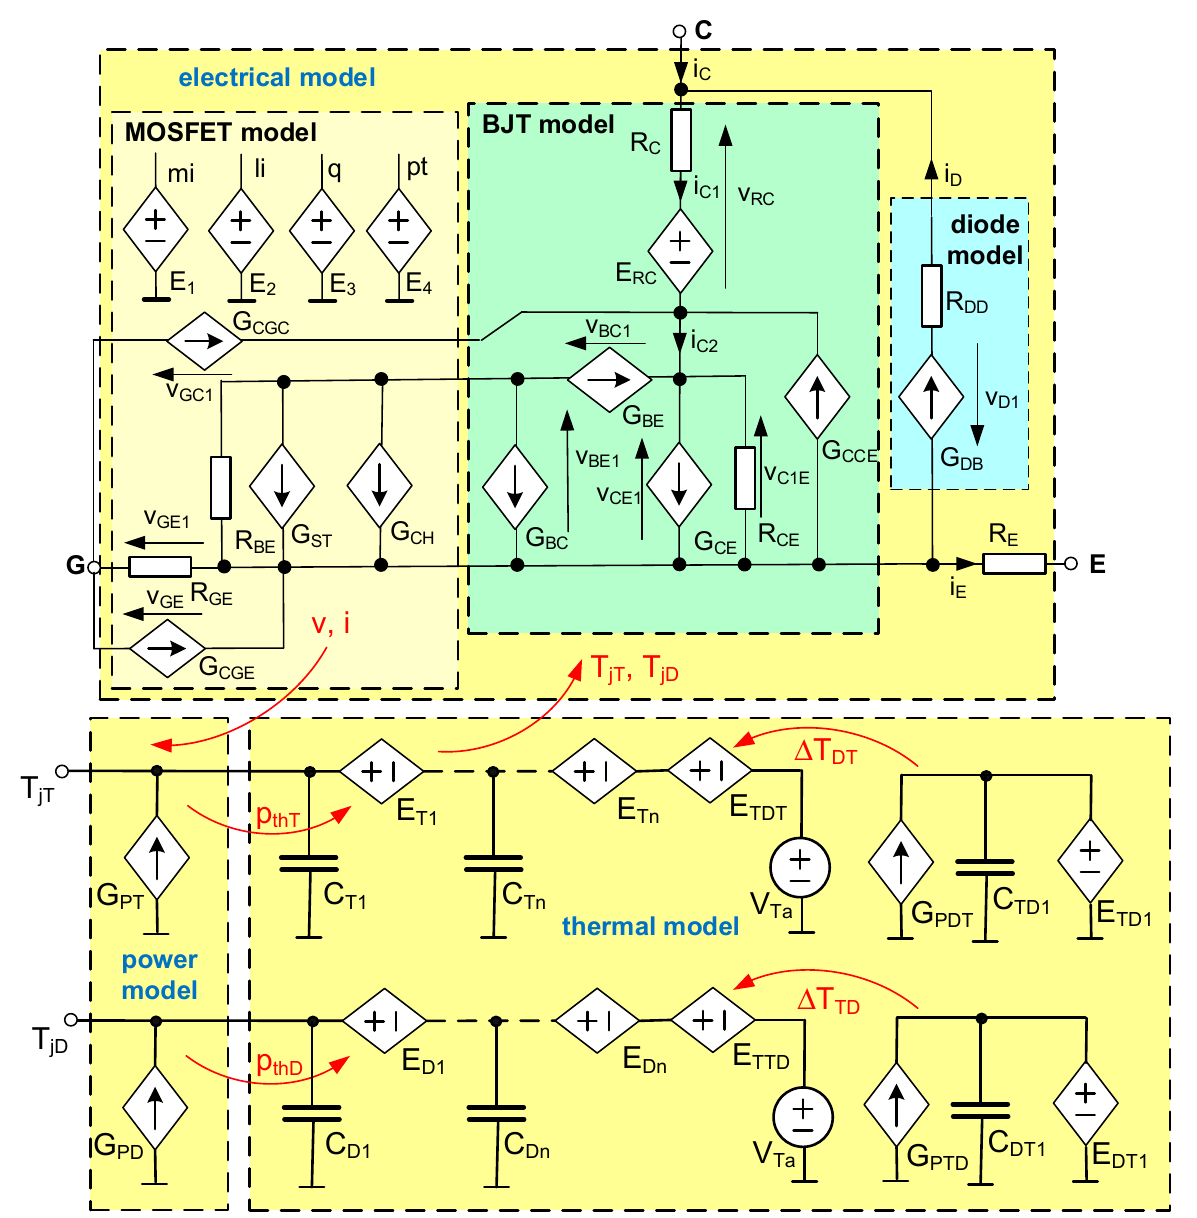
Figure 2. Network representation of a large-signal electrothermal model of the IGBT.